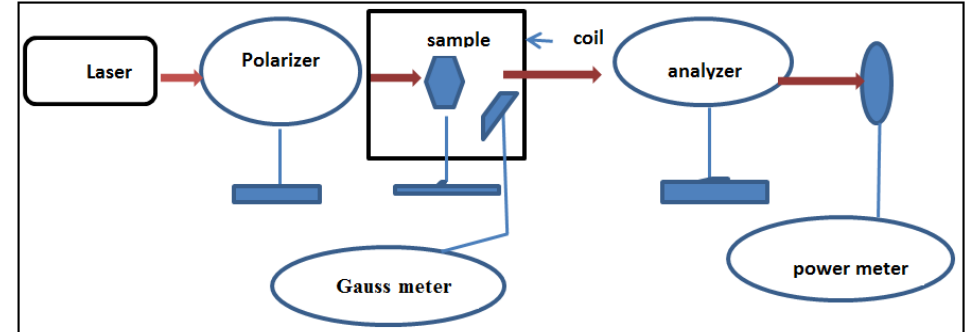
Fig.2: Schematic diagram of setup of magnetic switch.